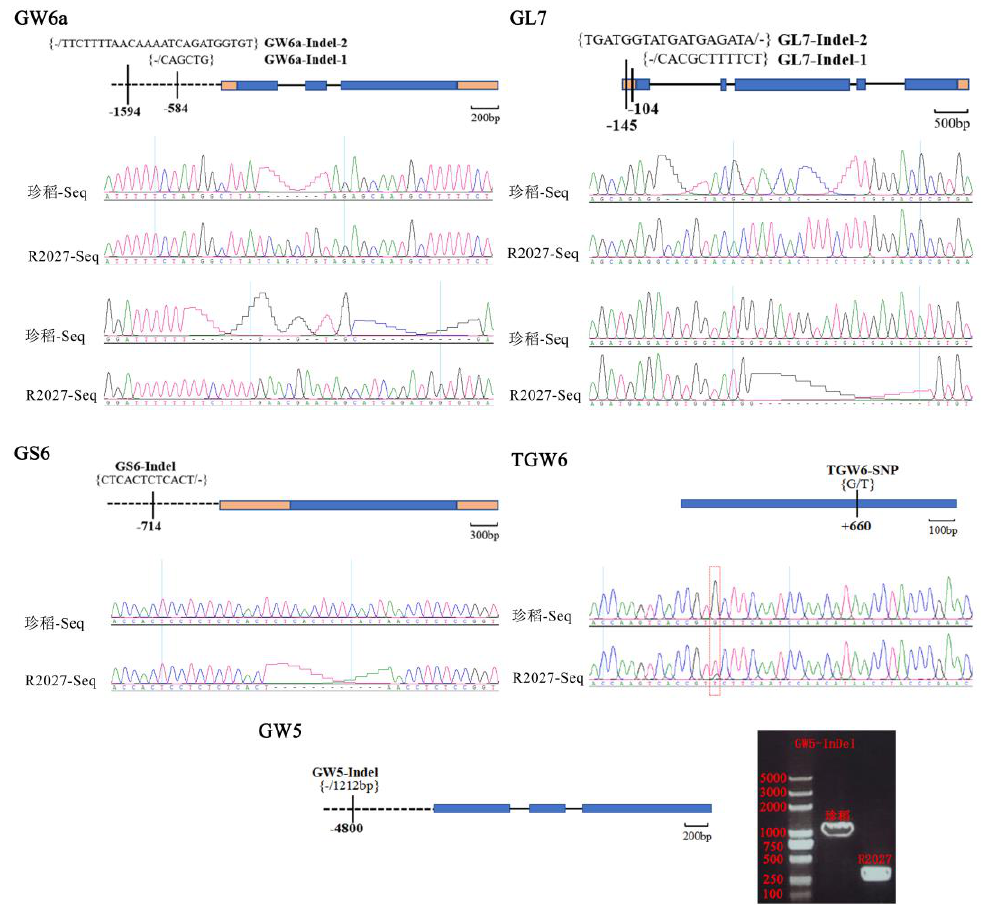
Figure 2. Position of the candidate SNP or InDel of five grain-size genes. The promoters, UTRs, exons and introns of the different genes are expressed as dashed lines, orange boxes, blue boxes and straight lines, respectively. The position of each variant is marked as the relative distance to ATG in the promoter ( − ) and CDS (+).